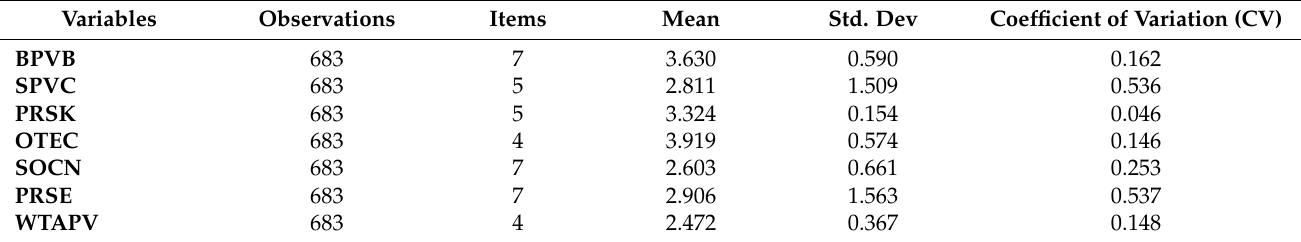
Table 4. Descriptive statistics of the data.